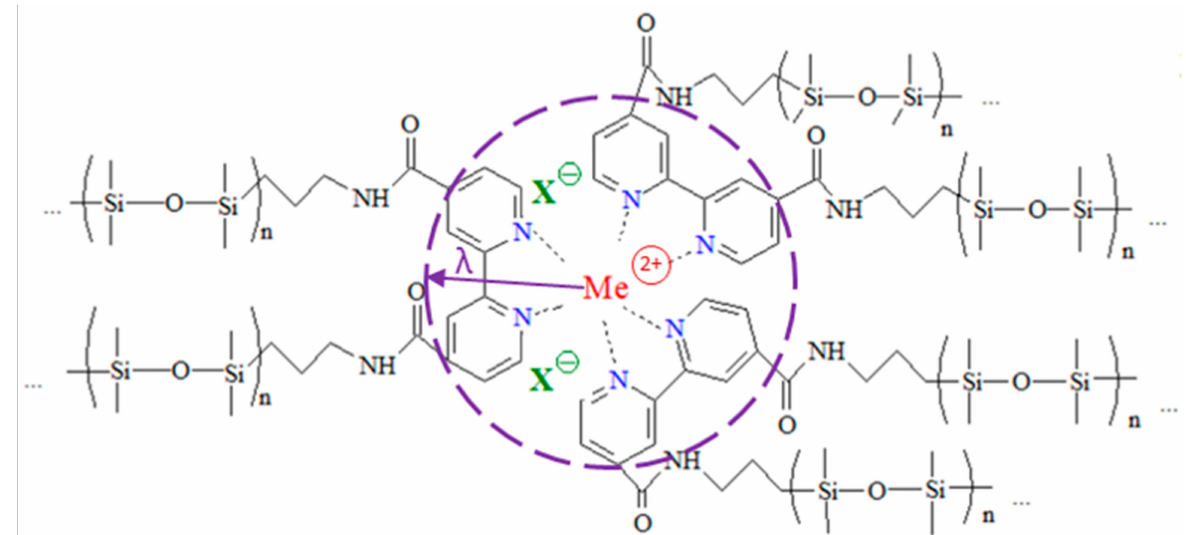
Figure 1. Molecular structure of bpyPDMS-MeX 2 investigated in this work (where Me 2+ : Ni 2+ , Mn 2+ , or Zn 2+ ; and X − : Cl − , Br − or I − ). Dashed line presents size of the Columbic cage, where λ corresponds to its average